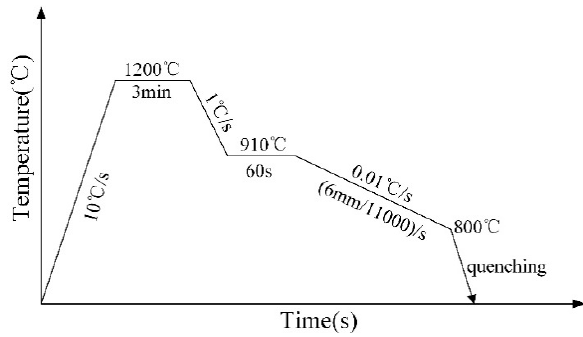
Figure 1. Schematic diagram of thermomechanical test profile for hot tensile test.